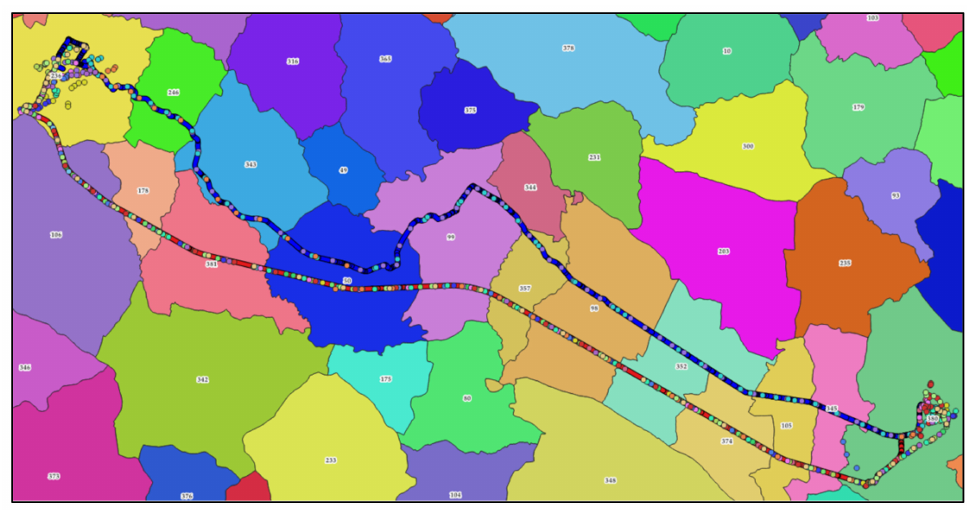
Figure 7. Lazio data: example of routes.